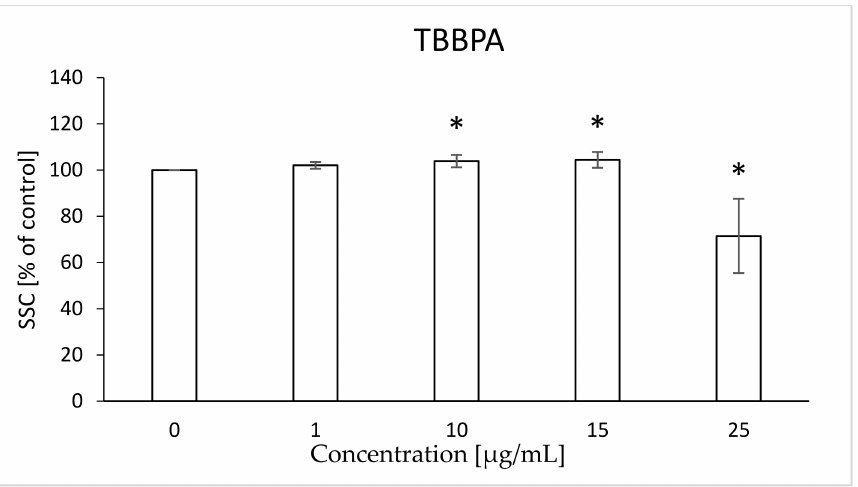
Figure 15. Changes in the SSC parameter in human control erythrocytes and the erythrocytes incubated with TBBPA at 1 to 25 µ g/mL for 48 h. (*) Significantly different from control ( p < 0.05).